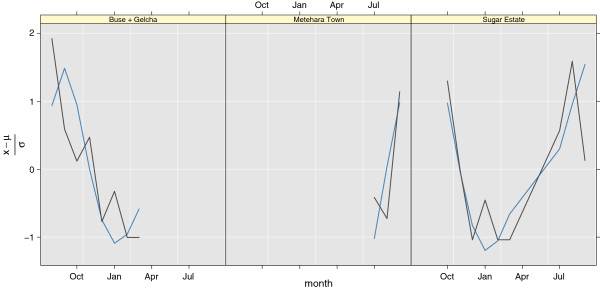
Scaled variations over time of adult An. arabiensis  in Awash, Ethiopia (BAL2001). Observed (grey solid line), and model (solid blue line).